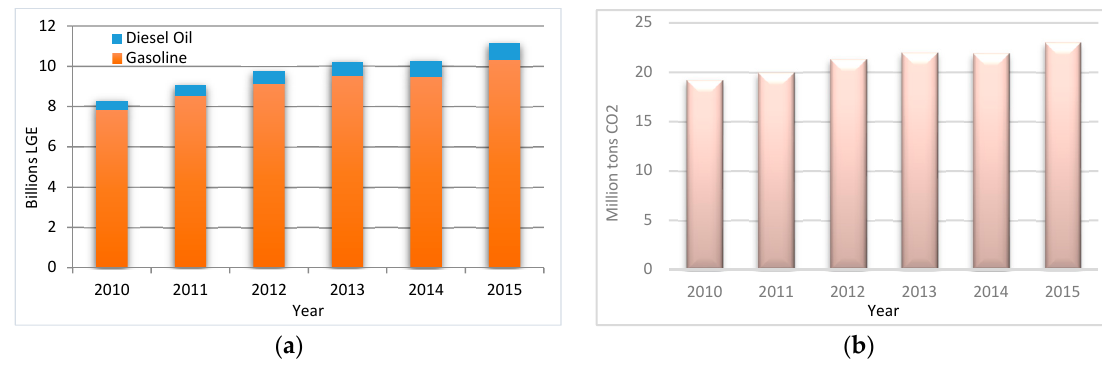
Figure 8. Historical ( a ) energy demand and ( b ) CO 2 emissions, 2010–2015.